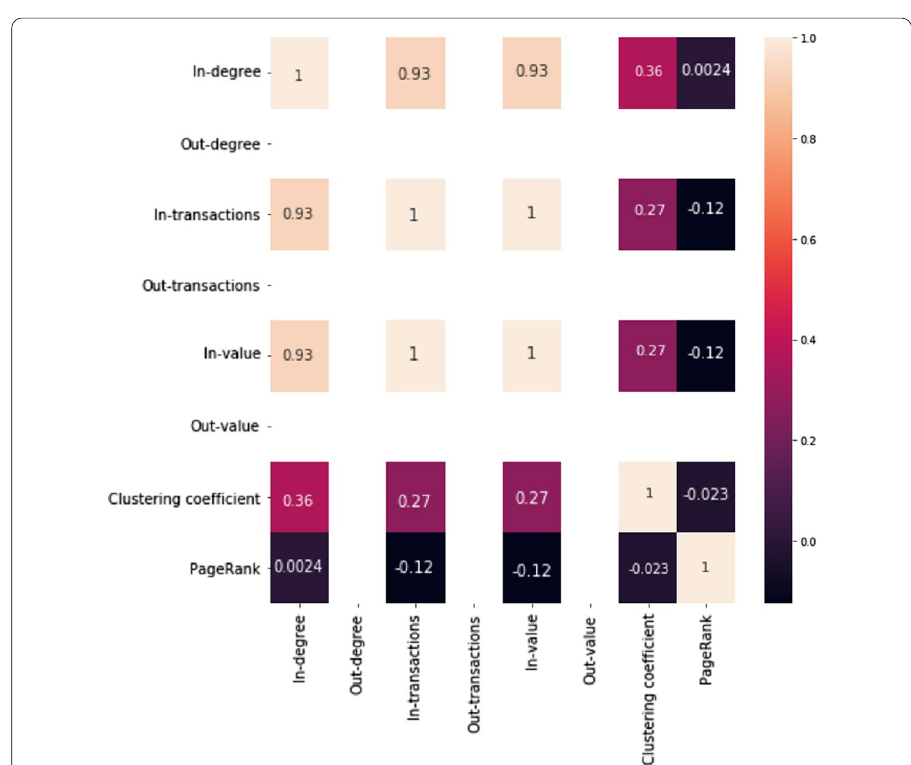
Fig. 9 Correlation matrix for the spectrum features of the class “Bancor”